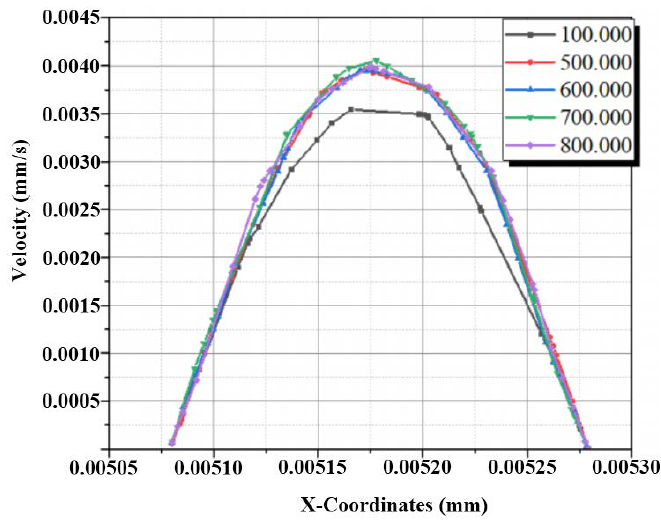
Figure 2. Evolutions of outlet velocities at the exit mid-line of X coordinates.